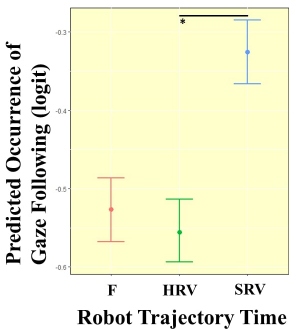
Figure 7: Spontaneous gaze following of participants during the study. Robot Trajectory Time (rTT) main effect on participants’ on the proportion of participants’ occurrence of gaze following behavior (F: 35.7% of total F events, HRV: 35.7% of total HRV events, SRV: 39.6% of total SRV events). Logit transformed predicted proportion is plot- ted on the y-axis. Vertical bars denote +/- 1 standard error. Horizontal bars denote differences surviving post hoc